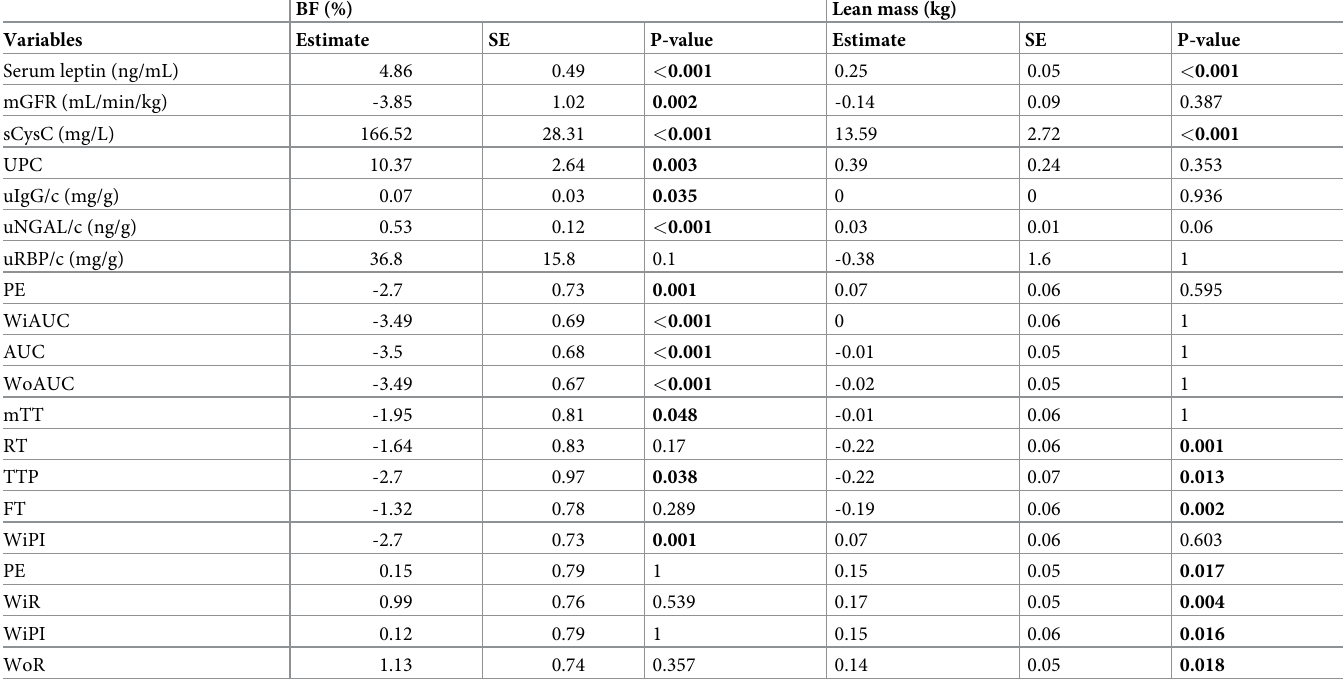
Table 2. Association of serum leptin, biomarkers of kidney function and kidney injury and CEUS renal perfusion variables with body fat (BF) percentage and lean mass (kg) within the weight-change group in dogs. BF (%) Lean mass (kg) Variables Estimate SE P-value Estimate SE P-value Serum leptin (ng/mL) 4.86